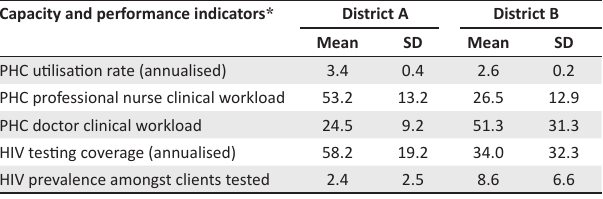
TABLE 5: Average district capacity and performance as of July 2014 based on national indicator data